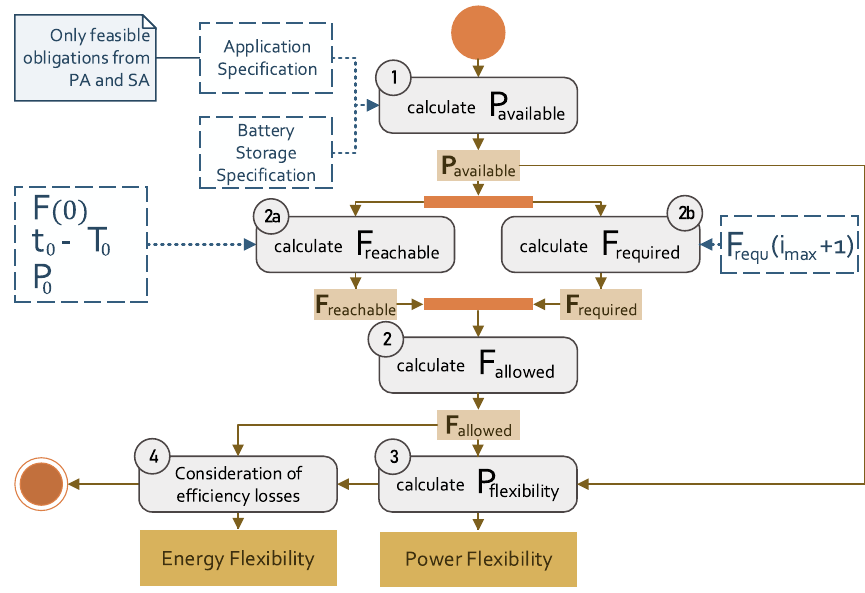
Fig. 1 Workflow of flexibility